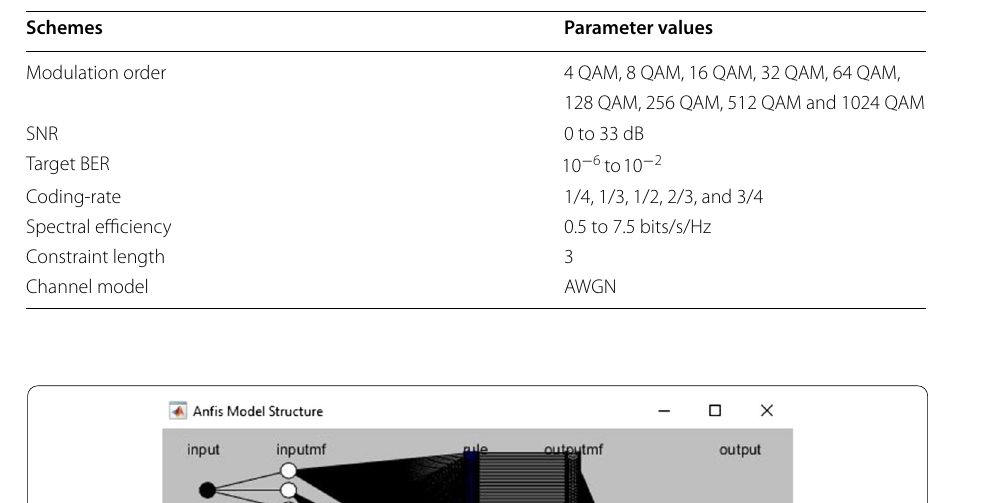
Table 4 System parameters and values